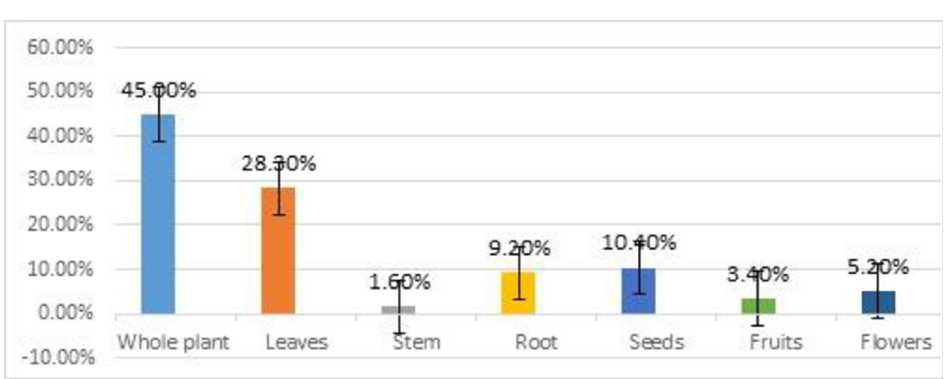
Fig 3. %age of plant parts used to treat different diseases of SMR of District Bhimber of AJK, Pakistan.